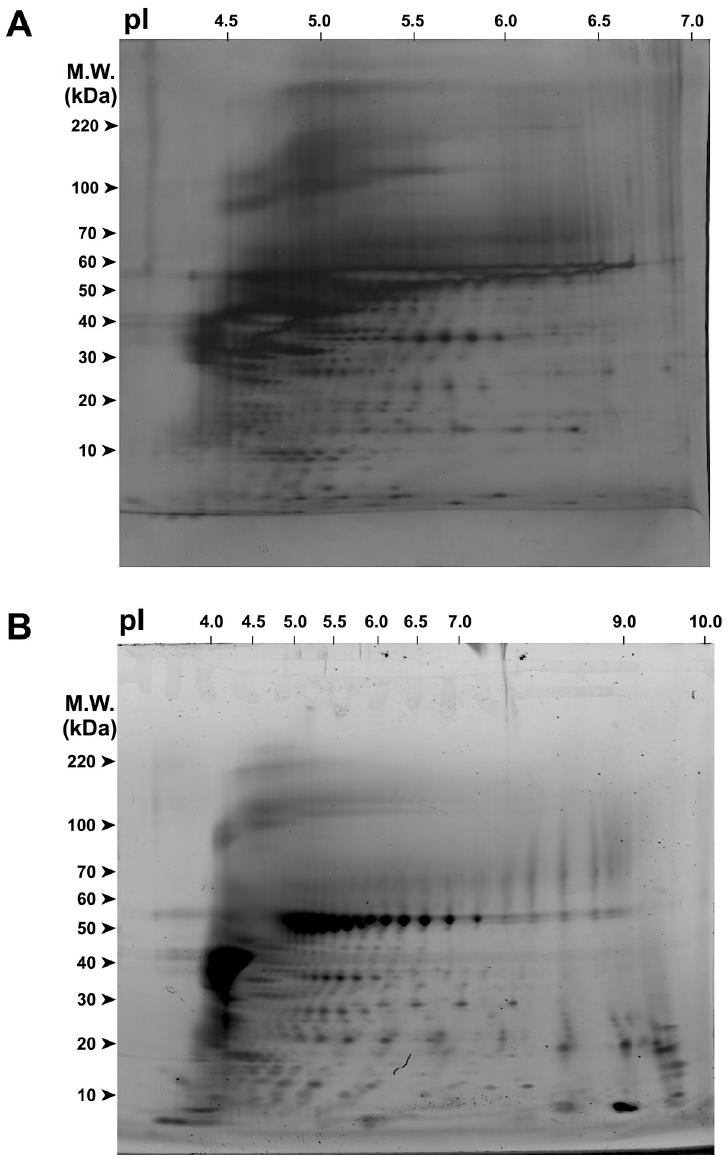
Fig 1. 2DE gel protein expression profiles of human hair shaft protein. (A) Conventional protocol. Proteins were separated in the first dimension on an IPG strip (pH 4–7; 13 cm) and in the second dimension on a hand-cast 8–15% gradient gel. Gel was silver-stained and scanned using Image Scanner III. (B) Modified protocol. Proteins were separated in the first dimension on an IPG strip (pH 3–10; 7 cm) and in the second dimension on a pre-cast 4–12% gradient gel. Gel was Sypro Ruby-stained and scanned using Typhoon FLA 9000 Scanner. Both gels were loaded with 100 μ g of hair protein with reference to result obtained from protein quantification.